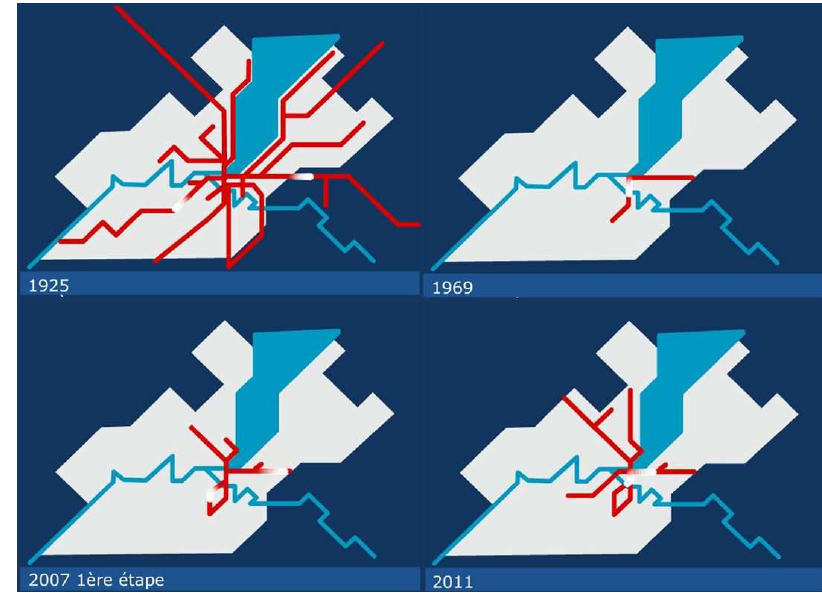
Figure 3. Demolition and redeployment of the tramway network in Geneva Legend : Geneva possessed one of the densest tramway networks in Europe in 1925, which has been then almost entirely dismantled in the 1950s to make space for automobile and finally redeployed from the 1990s. Source : Republique et Canton de